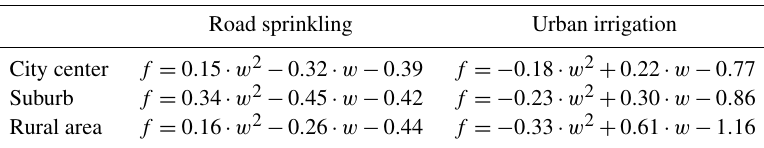
Figure 7. Temperature validation based on comparisons of simulations and reanalysis or in situ data. Left: spatial distribution of correlation coefficients between simulations and CLDAS reanalysis data. Right: (a) – (t) regression lines, RMSE values, and coefficient coefficients between simulations and in situ data. Table 4. Relationships between the amounts of water applied and cooling